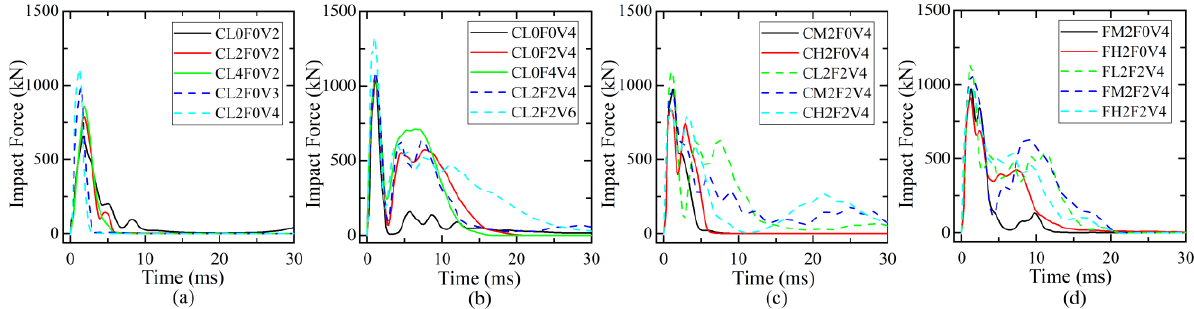
Figure 8. Parametric effects on time histories of impact force: ( a ) impact velocity and axial compression ratio; ( b ) number of CFRP layers and axial compression ratio; ( c ) impact height and number of CFRP layers; ( d ) impact height and number of CFRP layers.